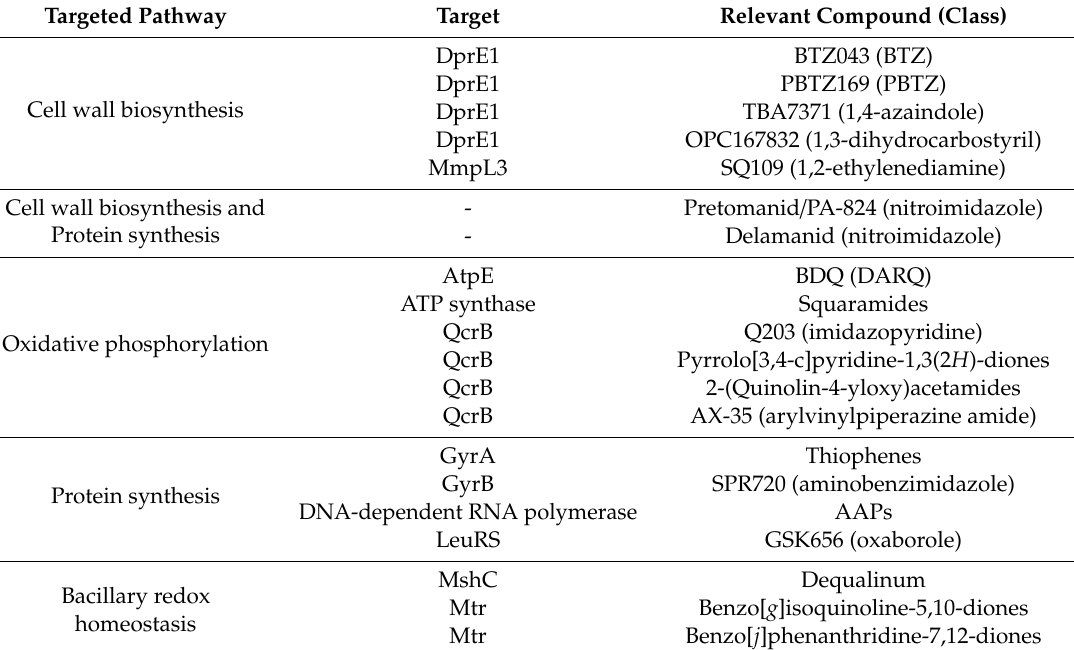
Table 1. Novel mycobacterial target examples and their relevant compounds or compound classes. Targeted